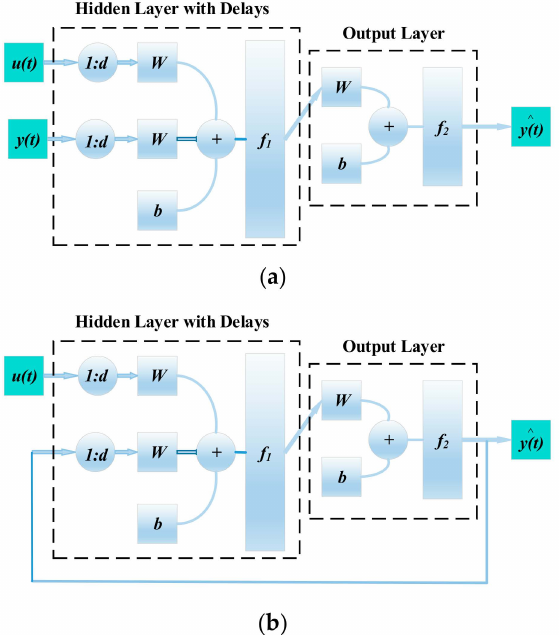
Figure 9. Typical configurations of the nonlinear autoregressive with external input (NARX) network during training. ( a ) Open-loop NARX network; ( b ) close-loop NARX